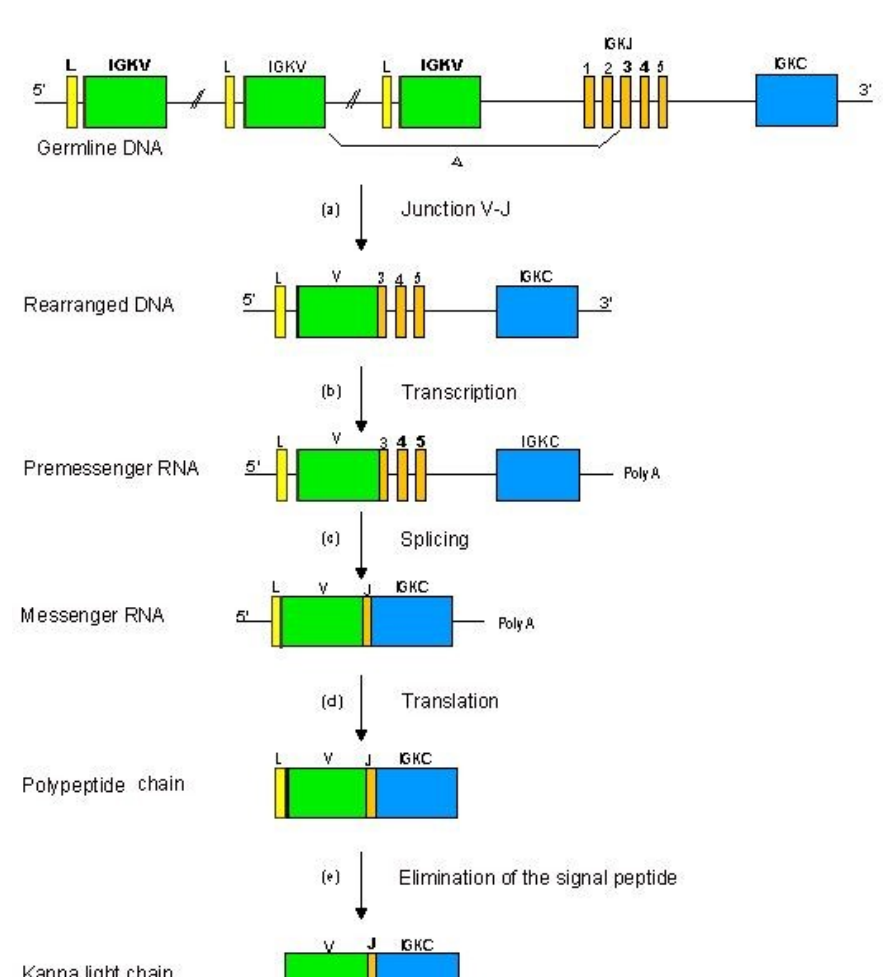
2.4.3. Synthesis of the L-Kappa and L-Lambda Chains: V-J Rearrangements in the IGK and IGL Loci The kappa (IGK) locus and the lambda (IGL) locus comprise variable (V), joining (J) and constant (C) genes. The variable domain of a L-kappa or L-lambda chain, V-KAPPA or V-LAMBDA, is a V-J-REGION, generated by the junction, at the DNA level, of two genes: a variable and a joining genes, with deletion of the intermediary DNA to create a rearranged IGKV-J gene in the IGK locus (Figure 8), or a IGLV-J gene in the IGL locus.